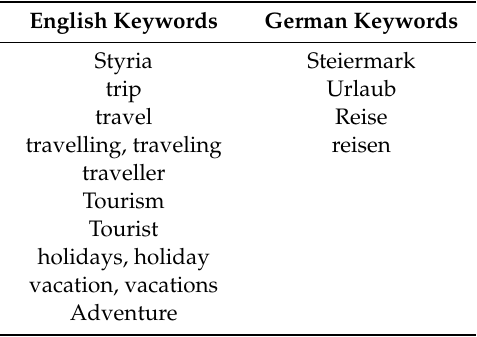
Table 1. The tourism related keywords to acquire Twitter data with the help of the Twitterscraper package. Table1. ThetourismrelatedkeywordstoacquireTwitterdatawiththehelpoftheTwitterscraperpackage.